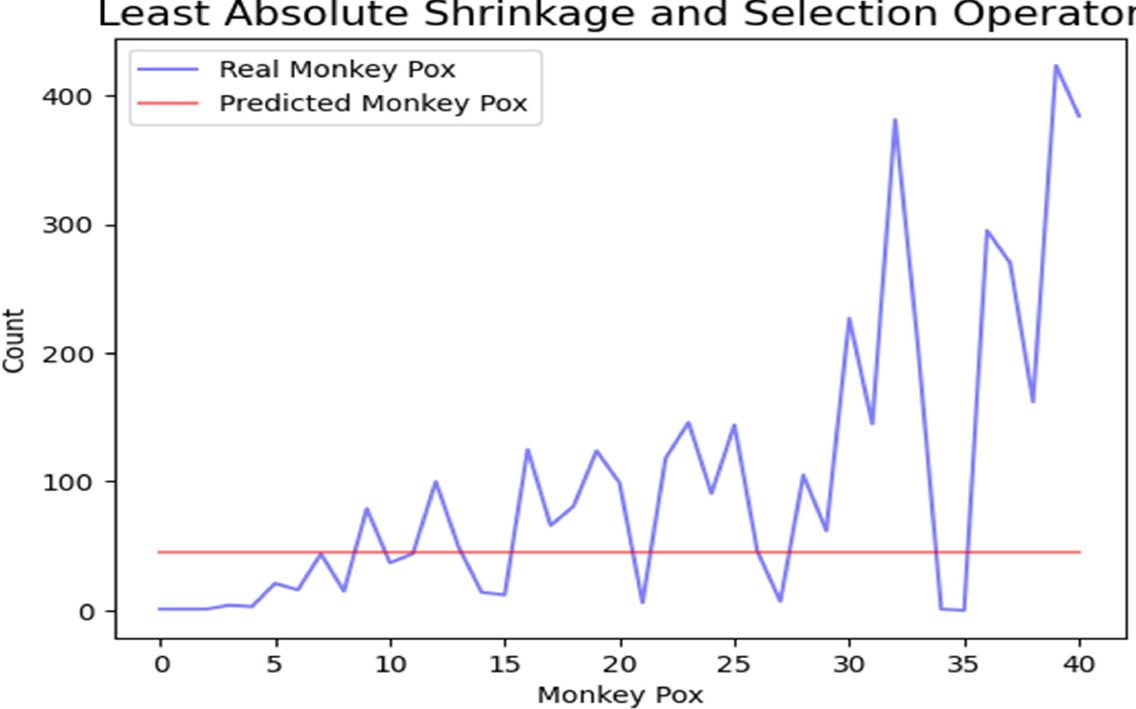
Figure 11. Time Series of Random Forest Algorithm.